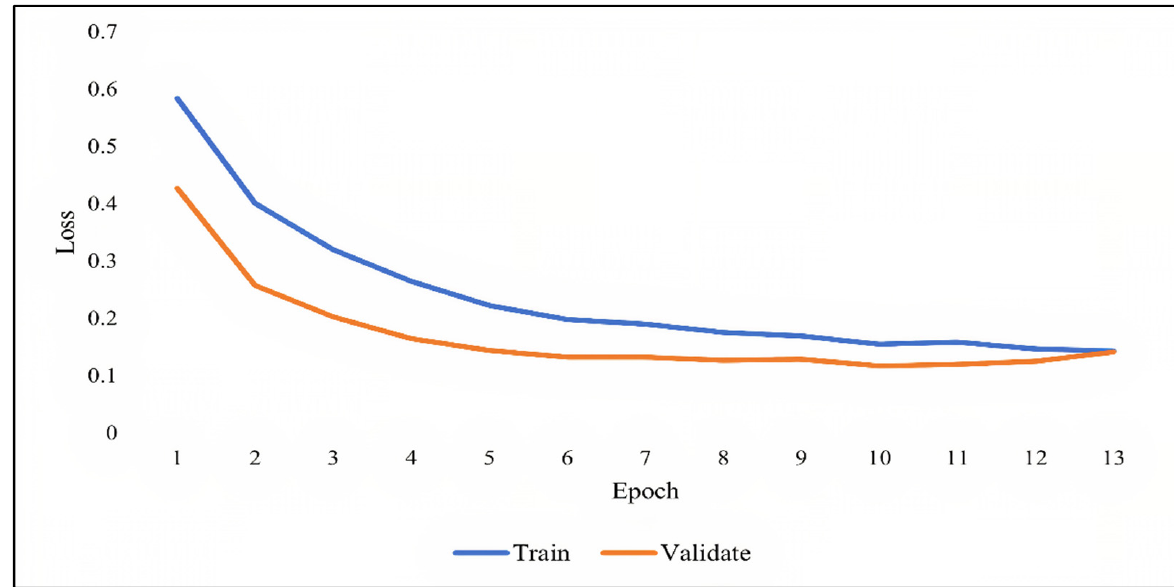
Figure 8. RNN learning curve during training.